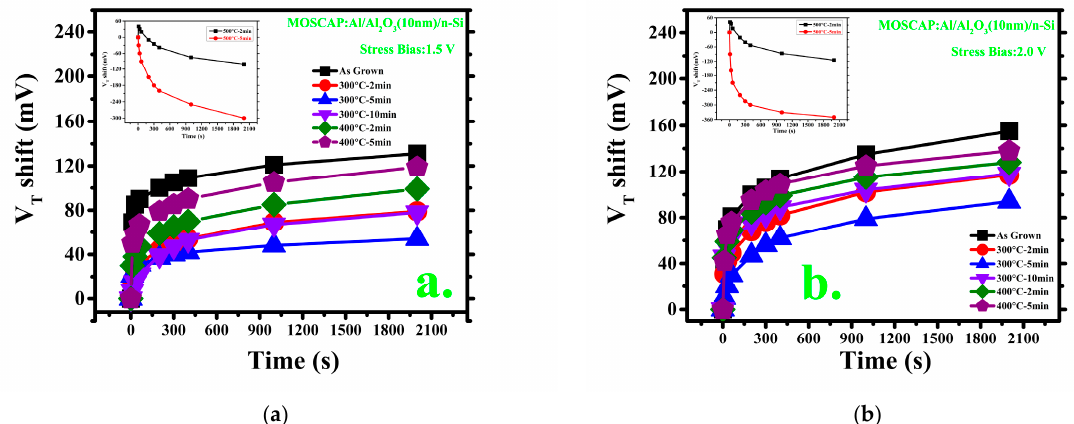
Figure 5. Threshold voltage shift after application of constant voltage stress for 2000s: ( a ) 1.5 V stress bias; ( b ) 2.0 V stress bias. Inset: 500 °C samples after stress application.